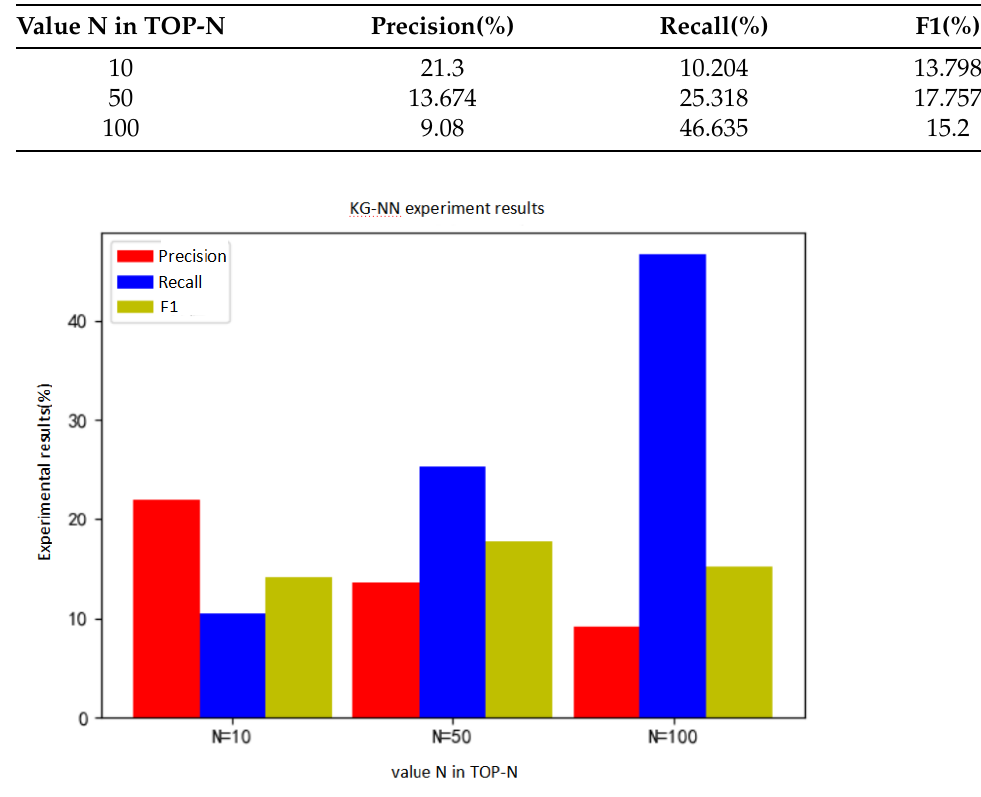
Table 7. Experimental results under different N values.